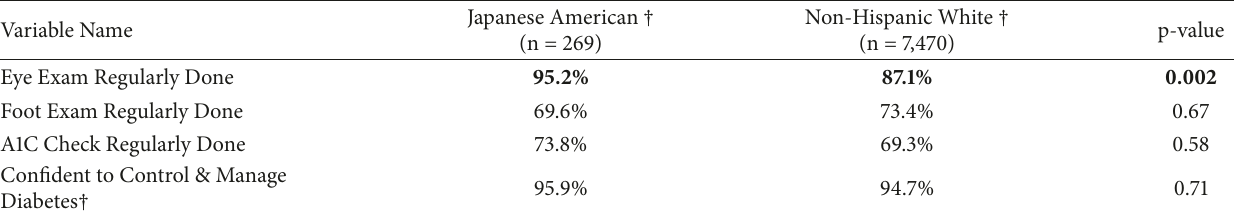
Table 3: Diabetes management behaviors of nonobese Japanese-American and non-Hispanic White cohorts